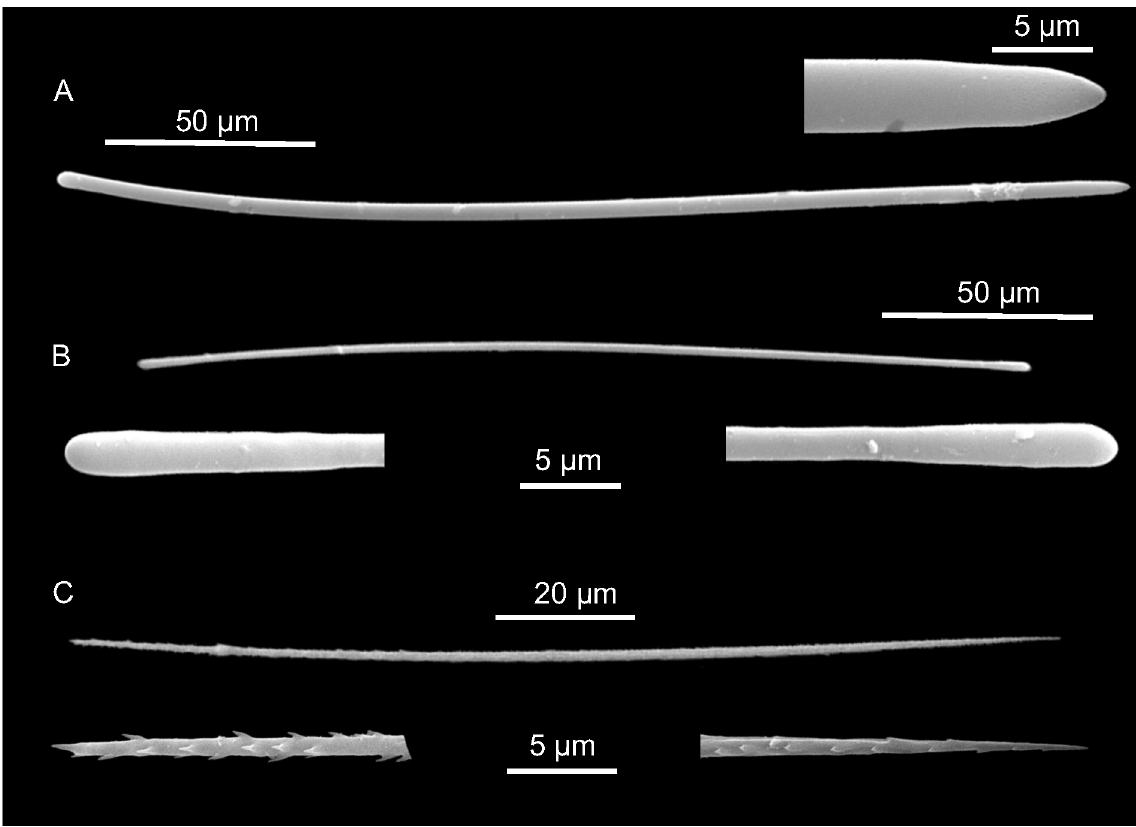
Fig. 23. Tedania sp., PdO5. A . Smooth style and magnification of the tip. B . Slightly curved tylote and magnification of the smooth tips. C . Onychaete and magnification of the